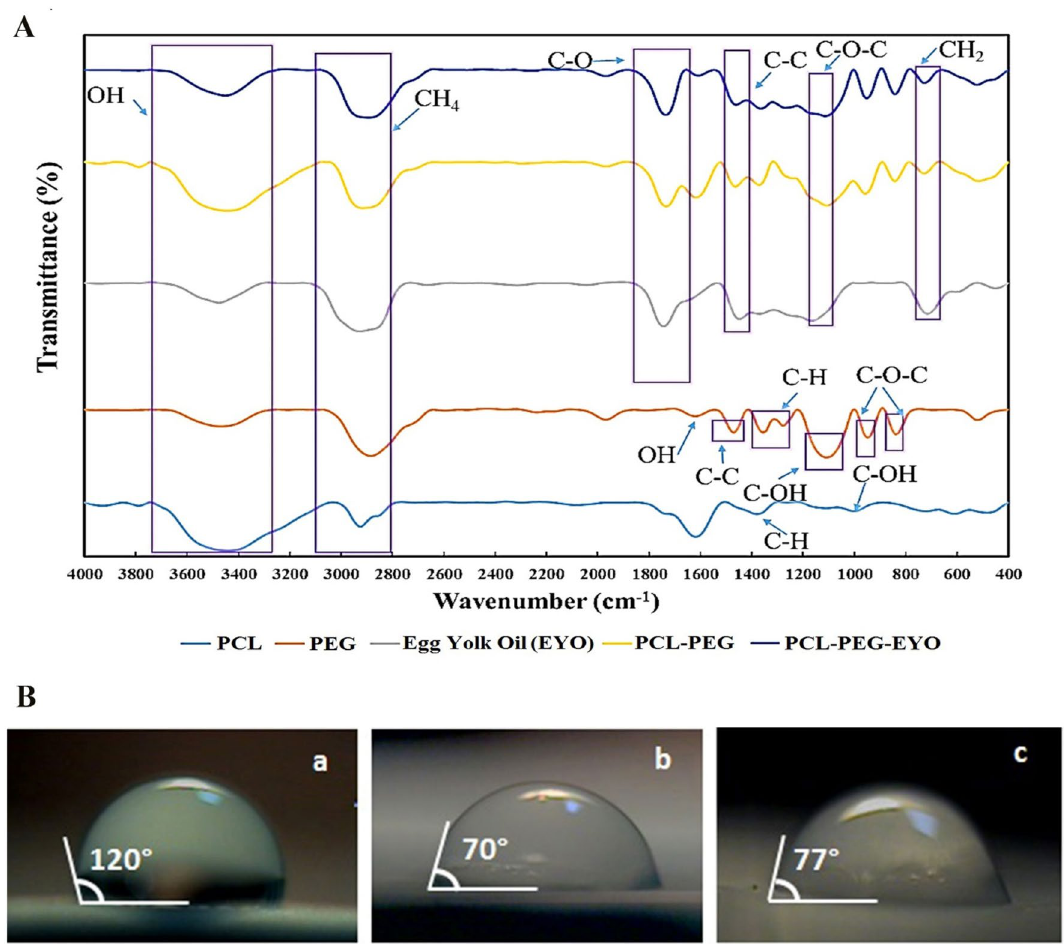
Figure 3. ( A ) FTIR spectra of PCL, PEG and EYO oil followed by the FTIR spectra of PCL-PEG and PCL- PEG-EYO nanofibrous webs; ( B ) Digital images of contact angle of water droplet on (a) PCL, (b) PCL-PEG and (c) PCL-PEG-EYO nanofibrous